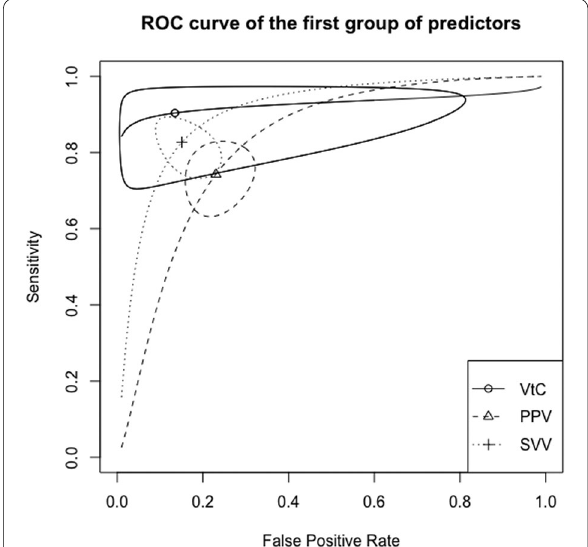
Fig. 3 Summary ROC curve for the second group of predictors of fluid responsiveness. IVC, inferior vena cava respiratory variability. Closed curve: 95% confidence